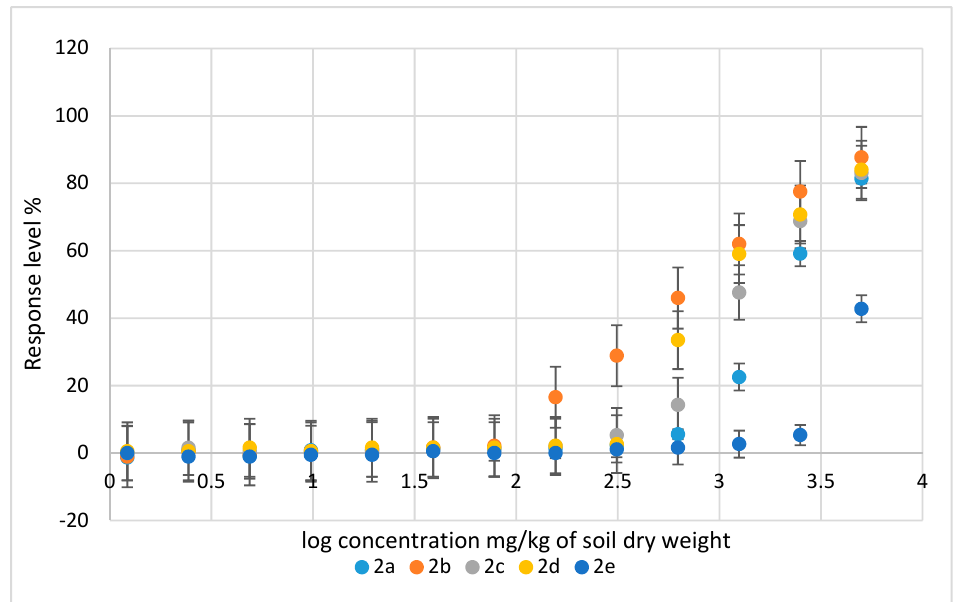
Figure 1. The EC 50 graded dose-response curved for the five tested aminophosphonates 2a – e . Overlapped curves are plotted by Microtox ® Analyzer 500 software. Error bars represent standard deviation errors (SD, n = 3 determinations).